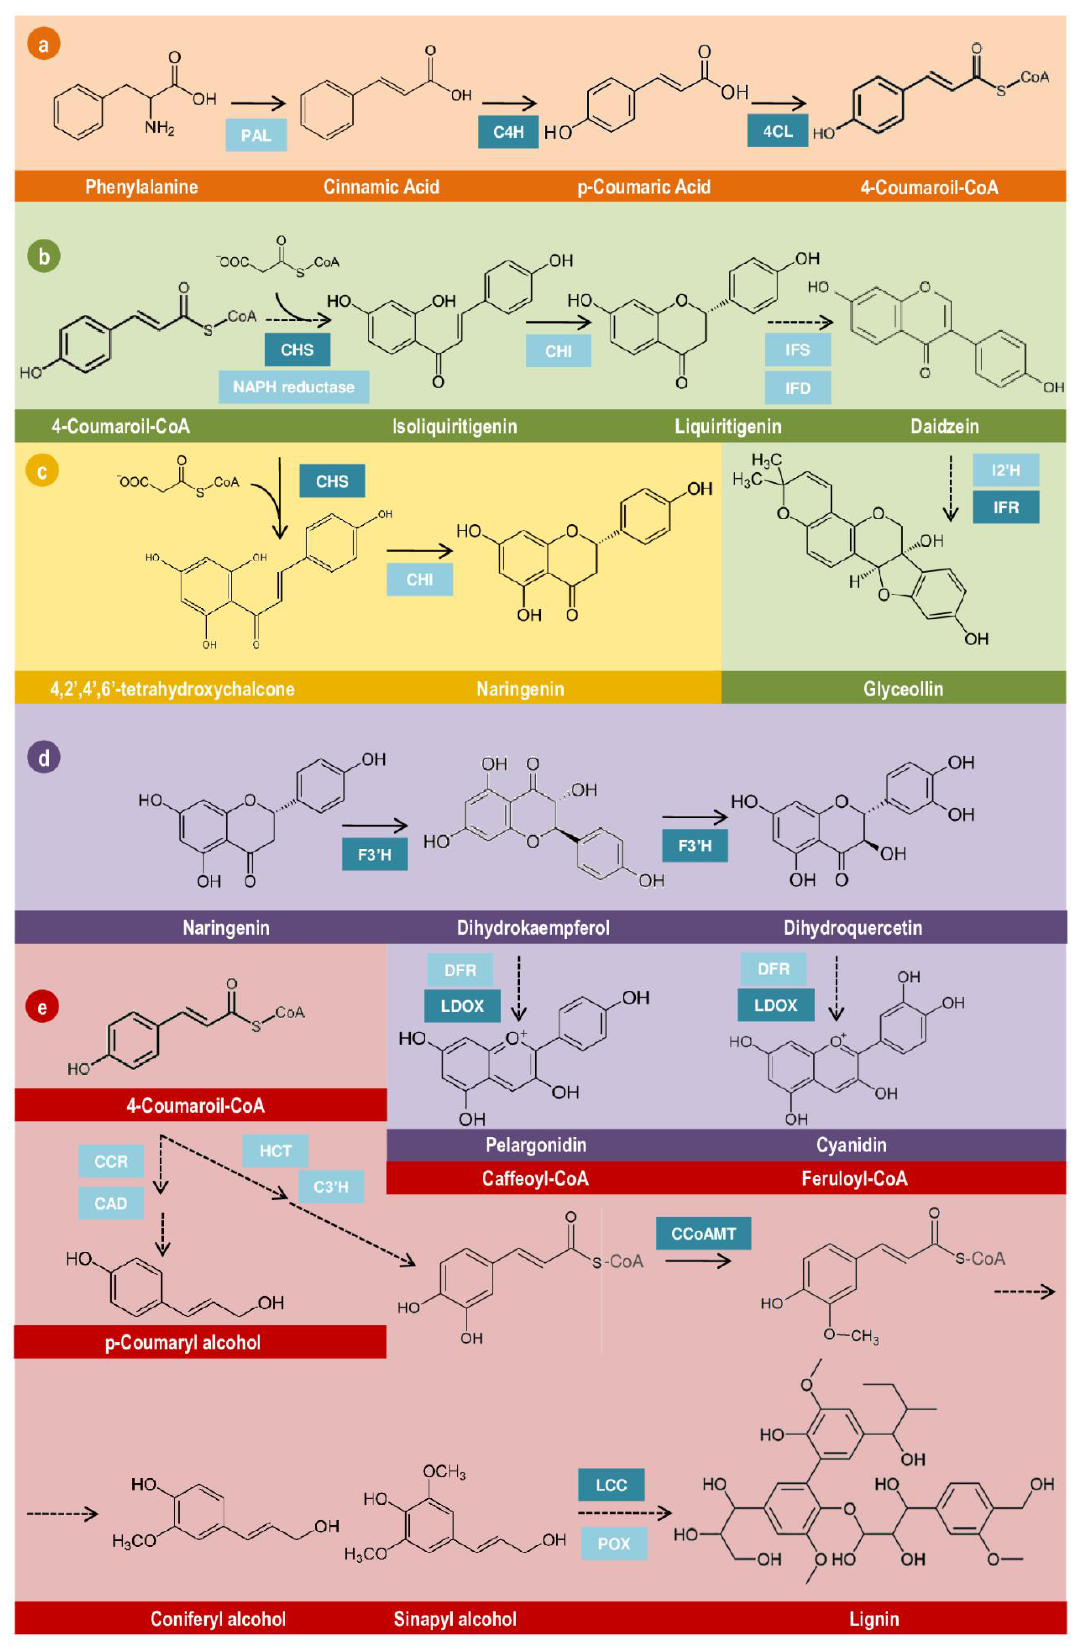
Figure 4. Phenylpropanoid-derived metabolic pathways associated with soybean tolerance to M. incognita